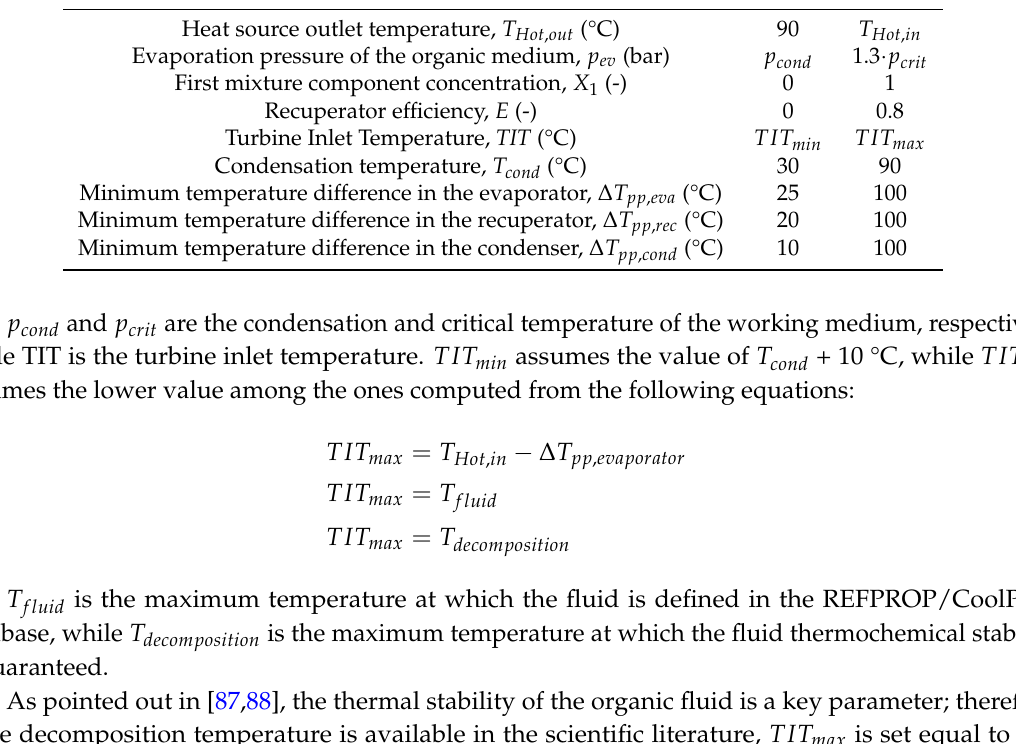
Table 4. Upper and lower bounds (UB and LB) fixed for the variables that are optimized.